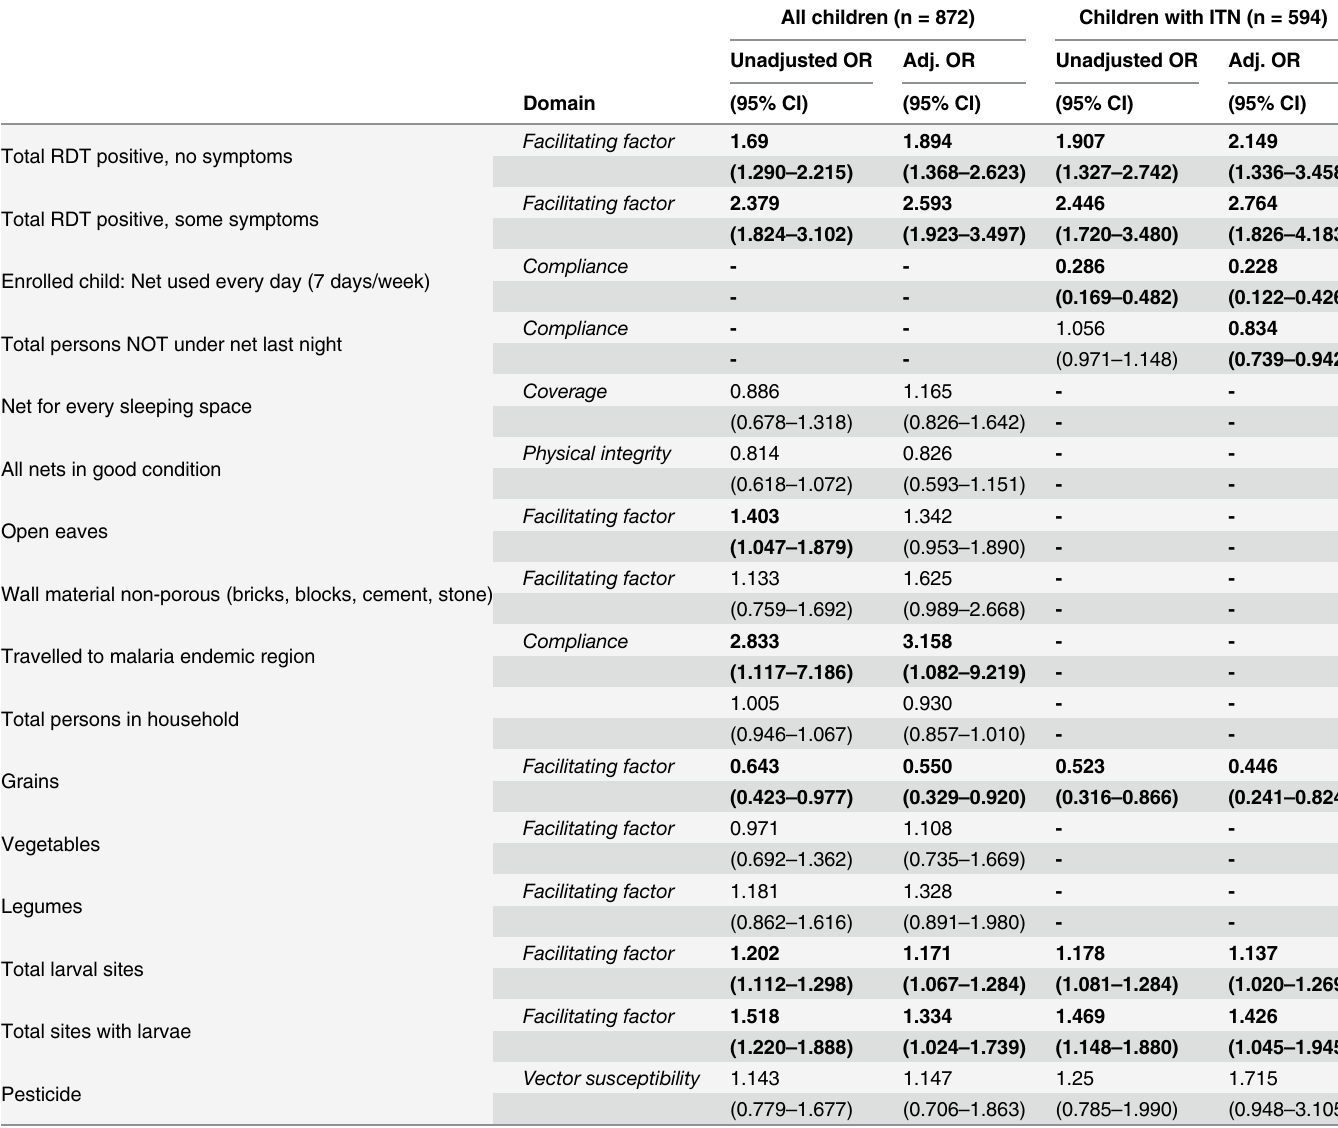
Table 3. Conditional logistic regression of variables related to malaria infection amongst all enrolled children and all children with a net for their sleeping